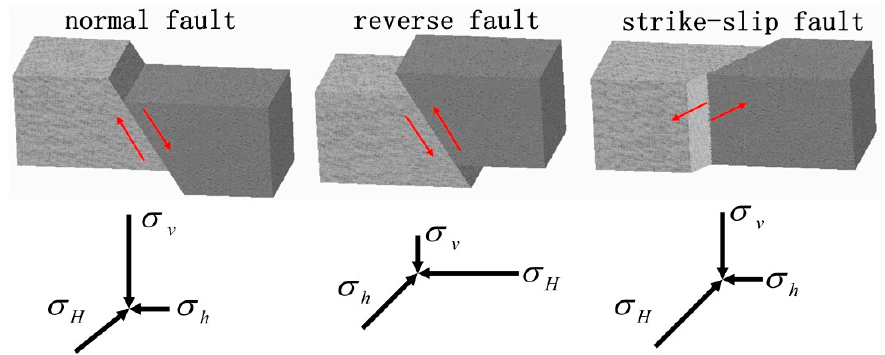
Figure 3. Schematic block diagrams showing the principle stress states of normal, reverse, and strike-slip faults. σ H and σ h are the major and minor horizontal principal stresses, σ v is the vertical principal stress.